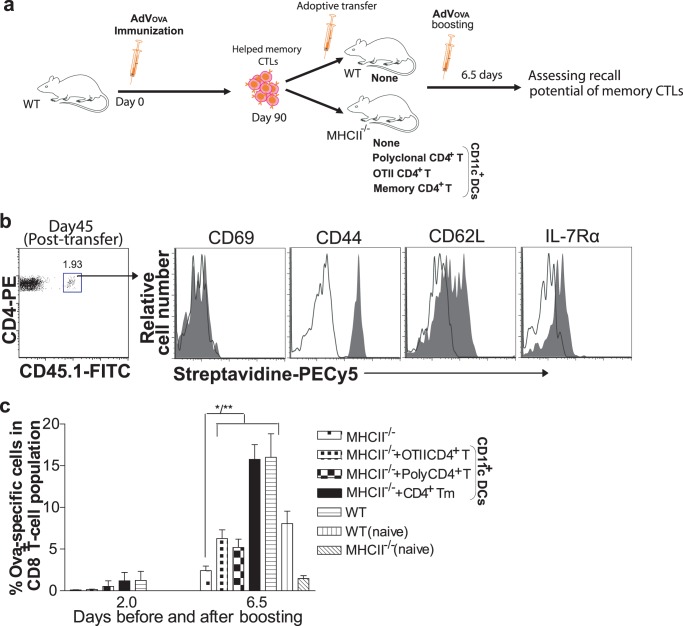
CD4+ T cell signals delivered during priming and recall phase are required for optimal secondary responses.(a) A schematic protocol. After 90 days following immunization, total CD8+ T cells containing memory CTLs were purified from WT (helped memory CTLs) mice and adoptively transferred equally to the naïve secondary recipients, WT and MHCII−/− mice (∼15×106/mouse). The MHCII−/− mice were additionally reconstituted with different types of CD4+ T cells (∼15–20×106/mouse) along with CD11c+ DCs (∼0.5–1.0×106/mouse). Both groups were boosted with AdVova and assessed for memory CTLs expansion. (b) Naïve B6.1/OTII CD4+ T cells were co-cultured with irradiated BM DCova, as detailed in material and methods to generate Th1 cells. Th1 cells were then transferred to naïve congenic WT mice (∼10–15×106/mouse). After 45 days, these cells were triple stained and phenotypically characterized for the expression of activation or memory markers (grey-shaded area) as shown in the figure. Irrelevant isotype-matched Abs were used as control (dotted thin lines). The value in the dot plot indicates % of OVA-specific CD4+ T memory cells remaining in total CD4+ T cell population. One representative of the two independent experiments is shown. (c) Naïve MHCII−/− mice were adoptively transferred with helped memory CTLs with naïve OTII T cells (∼1.5×106/mouse), polyclonal CD4+ T cells (∼15–20×106/mouse) or polyclonal CD4+ T cells containing OVA-specific memory CD4+ T cells (∼15–20×106/mouse) and CD11c+ DCs (∼0.5–1.0×106/mouse) as shown in Fig. 6a. Three days later, all the groups were boosted with AdVova and the recall potential of the memory CTLs were assessed 6.5 days later. The values represent mean %±SD of OVA-specific tetramer+ CTLs in total CD8+ T cell population and are representative of two independent experiments with four to five mice per group. *P<0.05 or **P<0.01, versus MHCII−/− mice with helped memory CTLs alone.